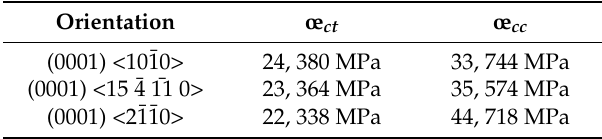
Table 2. MD results of critical tensile and compressive stresses.